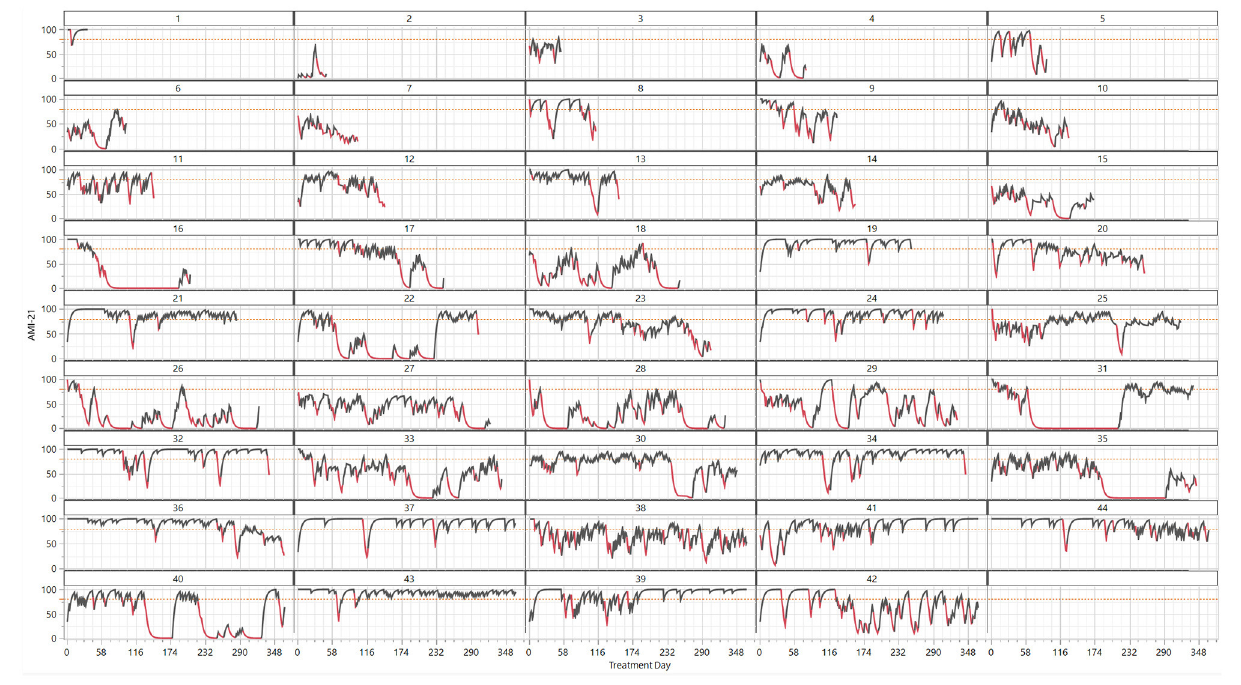
FIGURE 3 | Clinical course of 44 patients shown as treatment day time series (x-axis) of the digital biomarkers addiction monitoring index (AMI-21, y-axis) and exacerbation events of a length ≥ 2 (EE = 1, red; EE = 0, black). The patients are arranged by increasing treatment days, starting with early